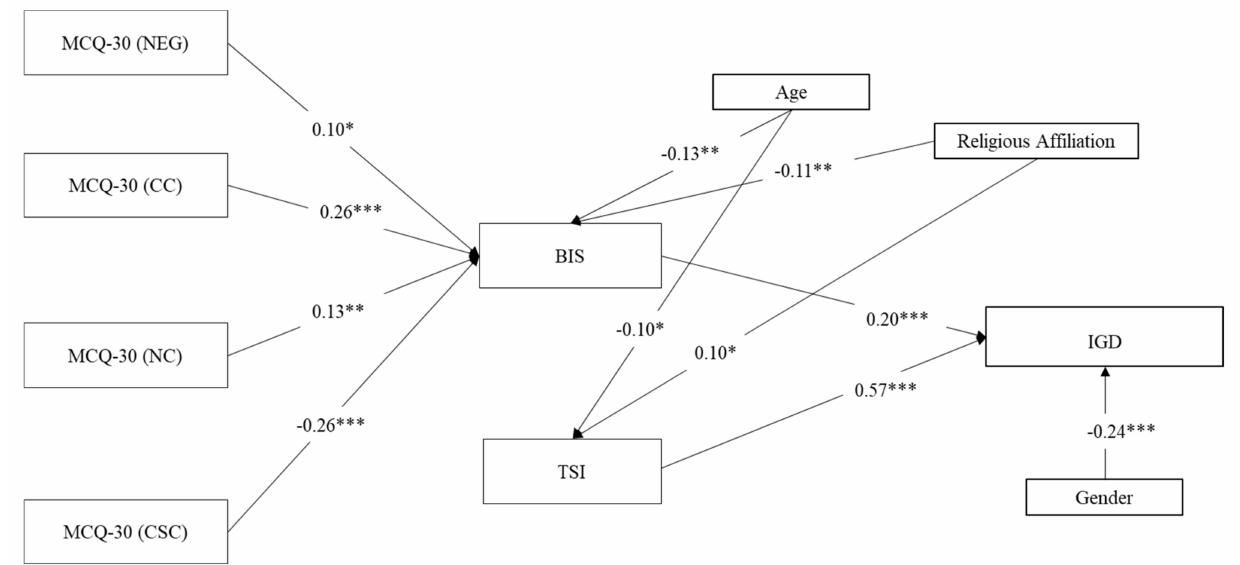
Figure 2. Results of the path analytical model with IGD as outcome variable. Notes: * p < 0.05, ** p < 0.001, *** p < 0.001; n = 471; Coefficients are standardized estimates; Religious Affiliation = (1 = Low, 2 = High); Gender: 1 = M, 2 = F; MCQ-30 (NEG) = Metacognitions Questionnaire-30 (Negative Beliefs about Thoughts concerning Uncontrollability and Danger); MCQ-30 (CC) = Metacognitions Questionnaire-30 (Cognitive Confidence); MCQ-30 (NC) = Metacognitions Questionnaire- 30 (Beliefs about the Need to Control Thoughts); MCQ-30 (CSC) = Metacognitions Questionnaire-30 (Cognitive Self- Consciousness); BIS = Barret Impulsivity Scale; TSI = Thought Suppression Inventory; IGD = Internet Gaming